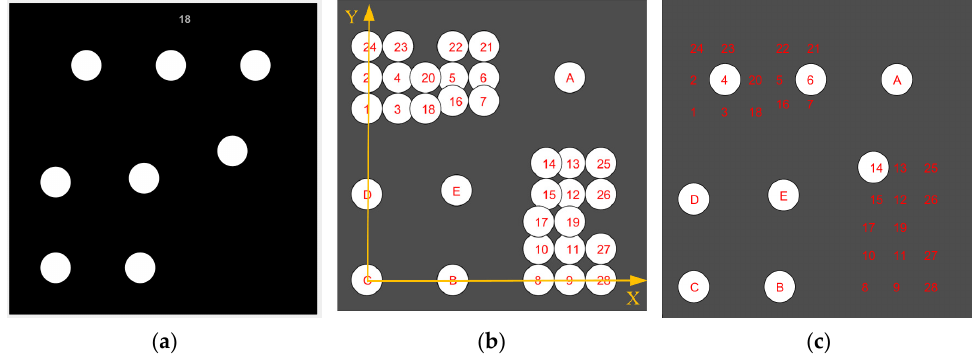
Figure 3. The structure of a GCT: ( a ) a GCT named CODE18; ( b ) deployment of all possible GCTs with identical template points; ( c ) the decoding points’ number and distribution of CODE18.